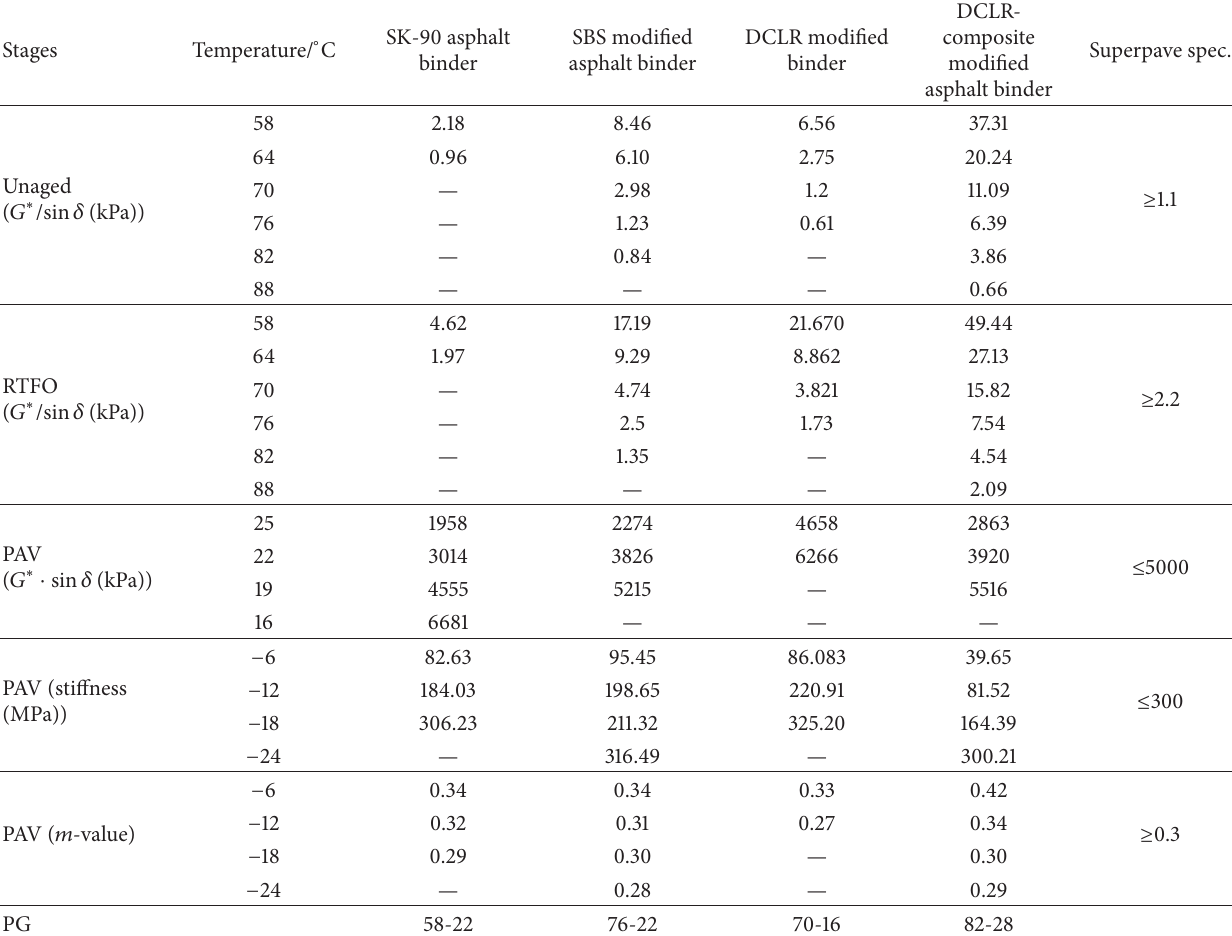
Table 3: Properties of the asphalt binders (SHRP PG